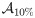
The five-parameter mortality model that we used in this study, featuring A: the duration of the juvenile stage, Ω: the age at the onset of actuarial senescence, aJ: the mortality hazard during the juvenile stage, a0: the mortality hazard during the prime-age adult stage, and b: the rate of actuarial senescence after the onset. In addition, we represent the 10% life span A10%: the predicted age at which 90% of the cohort is dead. The black dots represent the empirical mortality rates: proportion among individuals that reached age x of those that died before age x + 1. The data for this example come from captive lionesses (Panthera leo). The data for this figure are accessible online as S1 Data.